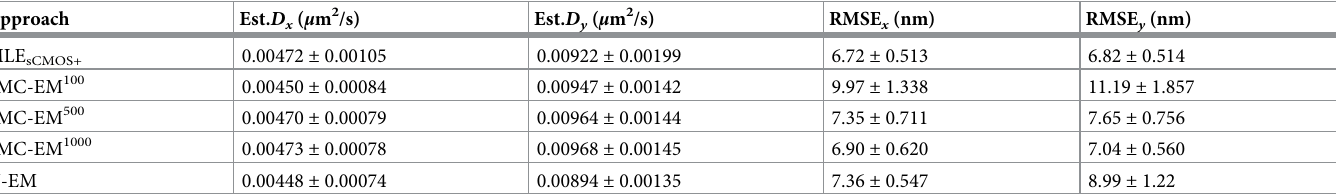
= 10, D = 0.005 μ m 2 /s, D = 0.01 μ m 2 /s with pixel-dependent readout noise. bgd x y